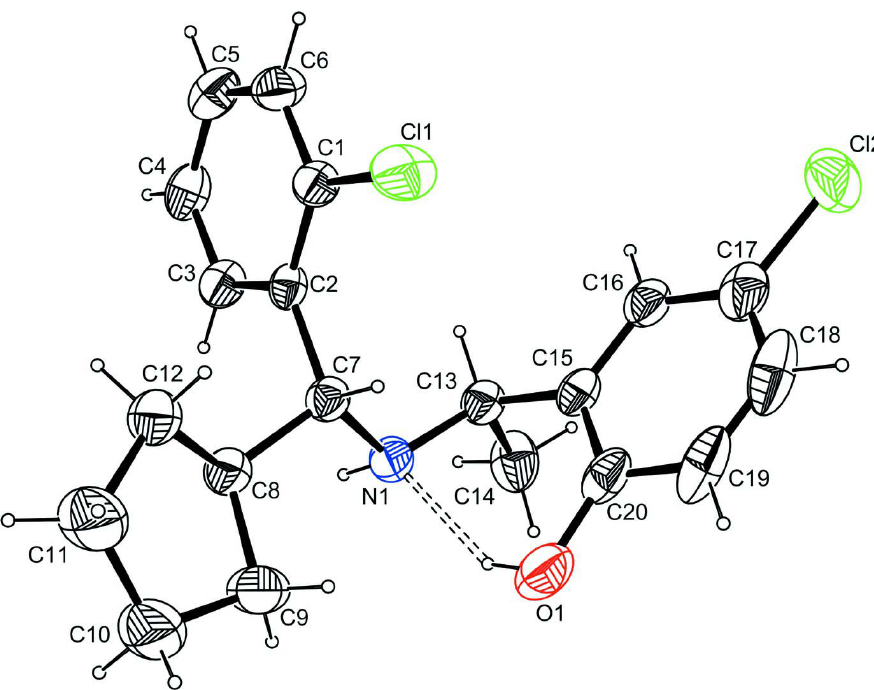
Figure 1 Molecular view of (I) with the atom-labeling scheme. Displacement ellipsoids are drawn at the 30% probability level. H atoms are shown as small spheres of arbitrary radii. H bond is shown as dashed